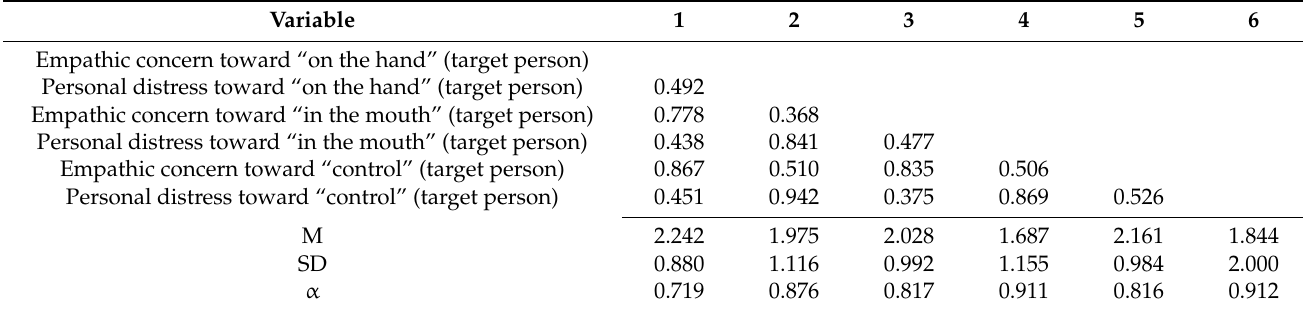
Table 2. Descriptive statistics for the study 2